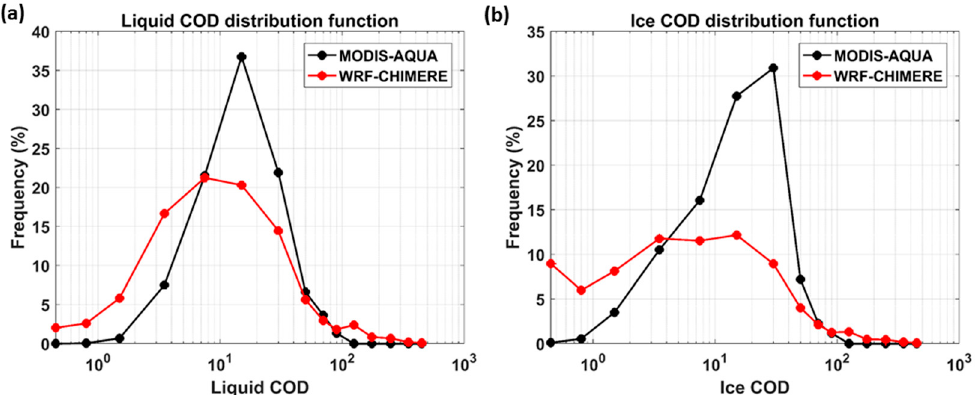
Figure 11. Comparison between MODIS-Aqua and modelled distribution functions of ( a ) liquid cloud optical depth and ( b ) ice cloud optical depth.